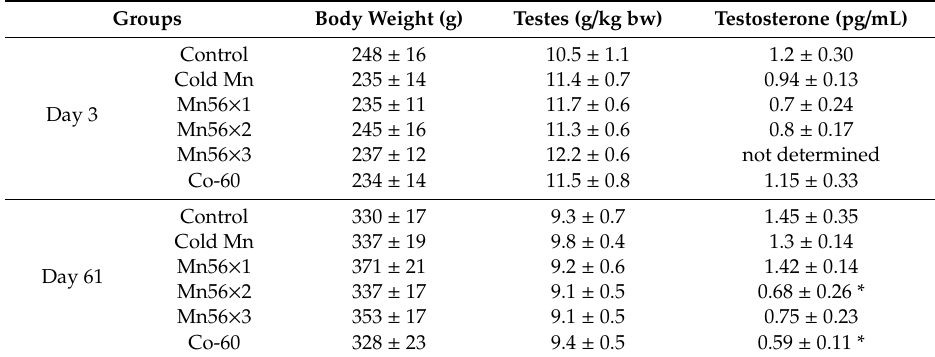
Table 1. Body and testis weights and serum testosterone in rats exposed to 56 MnO 2 , 60 Co γ -rays, and cold MnO 2 .